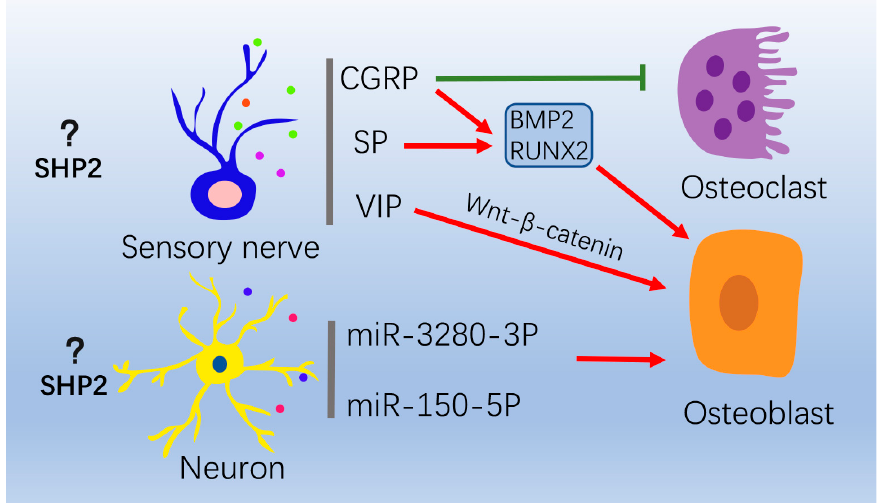
Figure 3. The role of the nervous system on osteoblasts and osteoclasts. In peripheral nervous system, sensory and sympathetic nerves secrete neurotransmitters to regulate bone formation and resorption. CGRP suppresses osteoclasts formation. CGRP and SP promotes osteogenesis via increasing BMP2 and RUNX2 expression. VIP promotes osteogenesis through WNT/ β -catenin signaling. In central nervous system, neurons can release extracellular vesicles enriched with miR-328a-3P and miR-150-5P to promote osteogenesis. “Red arrow” refers to promotion; “Green arrow” refers to inhibition.